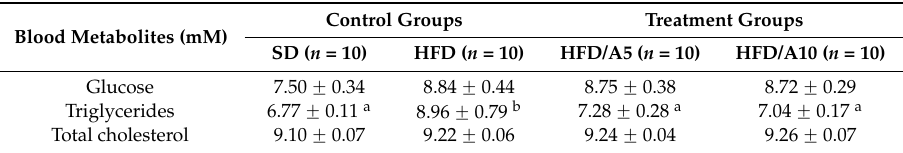
Table 2. Effects of fructans on blood metabolites in all groups of mice in the 10 th